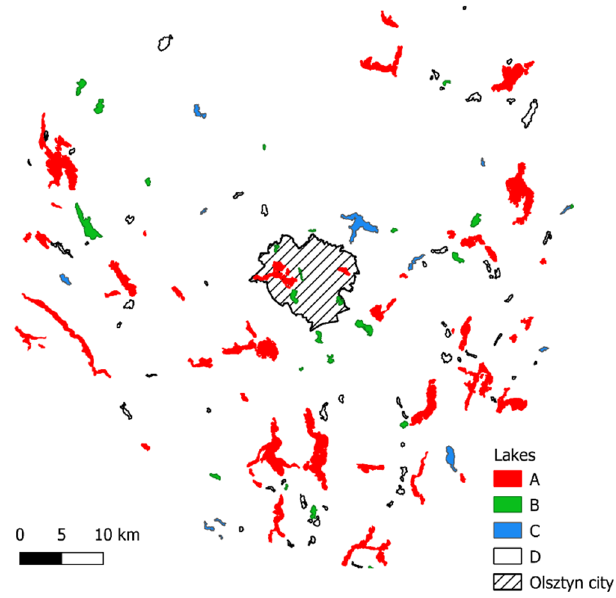
Figure 3. Distribution of lakes belonging to particular LU/LC types (categories).